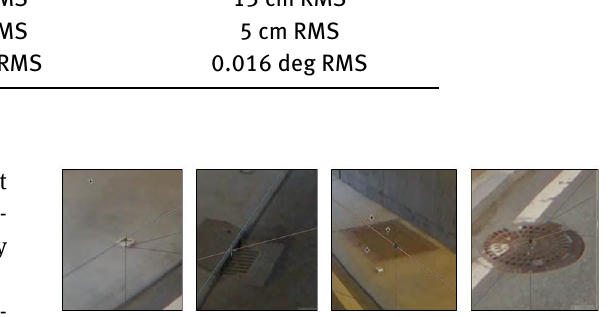
Figure 3: Sample examples of object types used in the measure- ment campaign (lamp, reflector mark, storm drain,